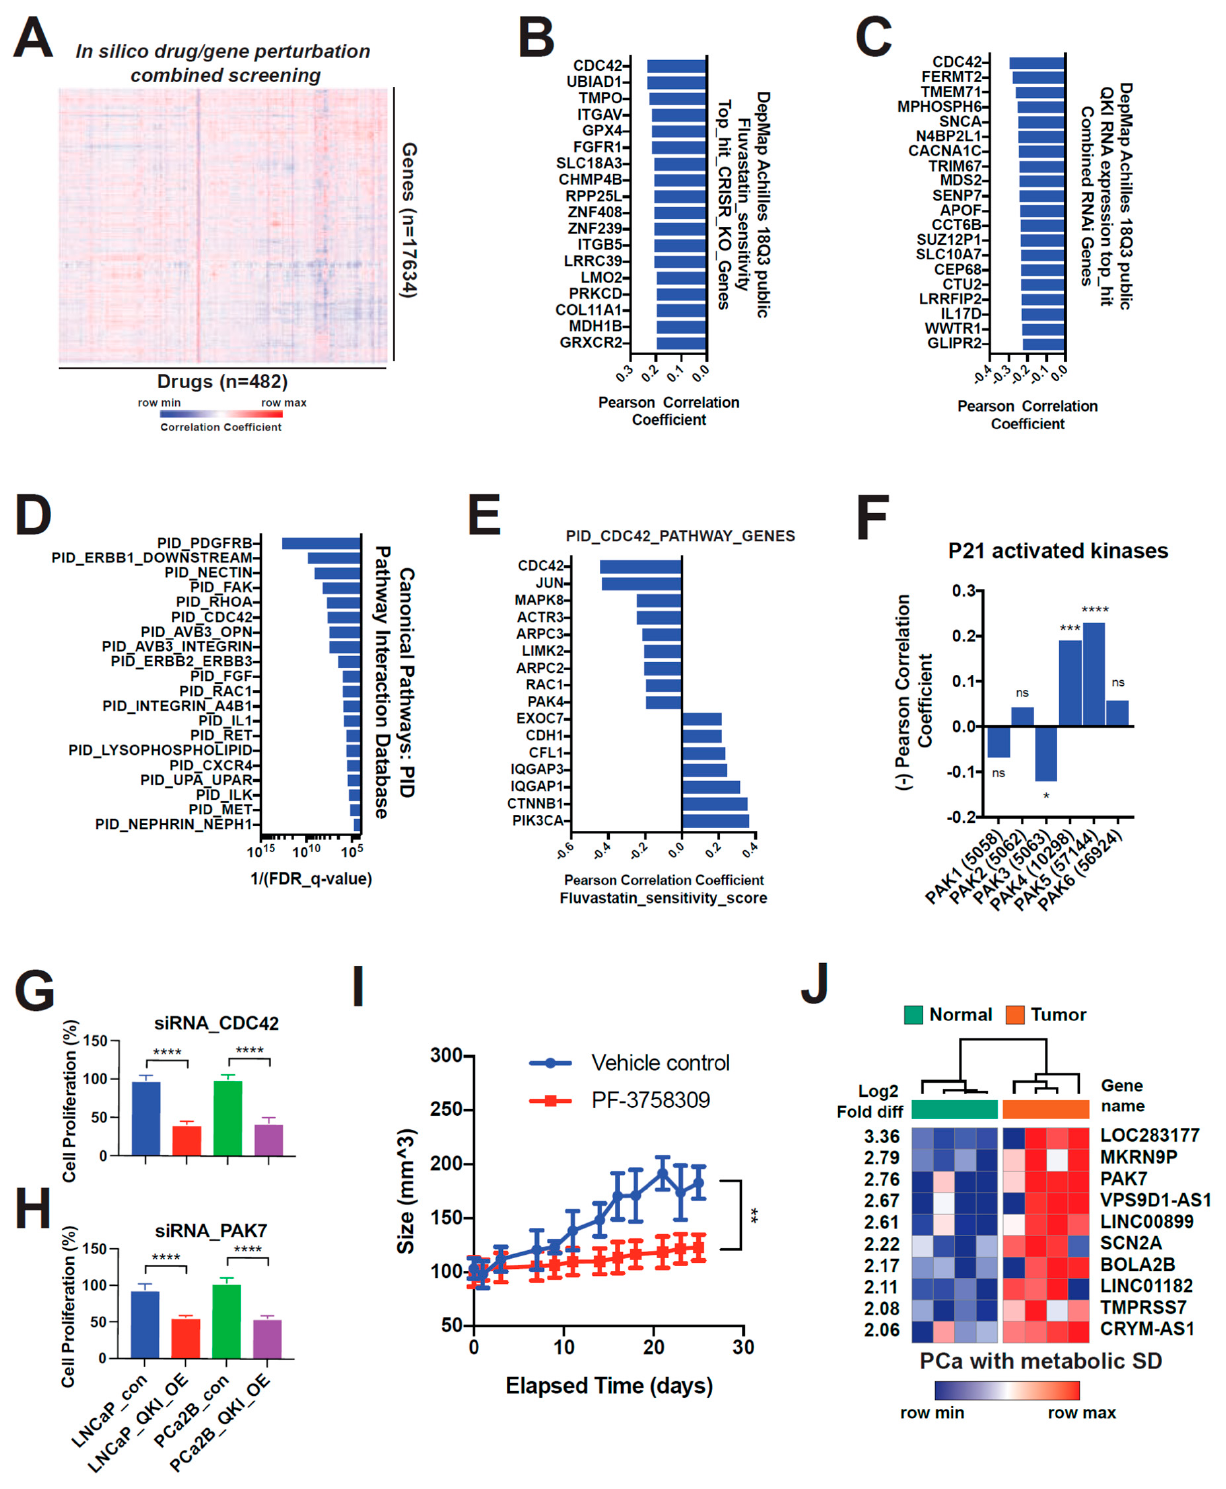
matched normal, Figure S4A). Nevertheless, PAK7 expression positively correlated with QKI expression in both tumor tissues and normal tissues (Figure S4B).